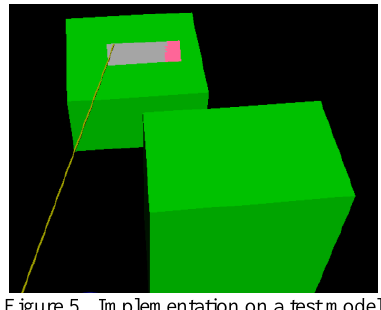
Figure 5. Implementation on a test